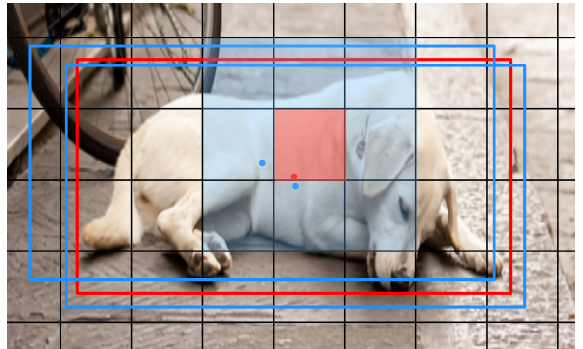
Figure 6. Positive samples selection for training. Ground truth boxes (in red) still have high IoU with prediction boxes (in blue), although their centers are positive (in red mask) and negative (in blue mask),